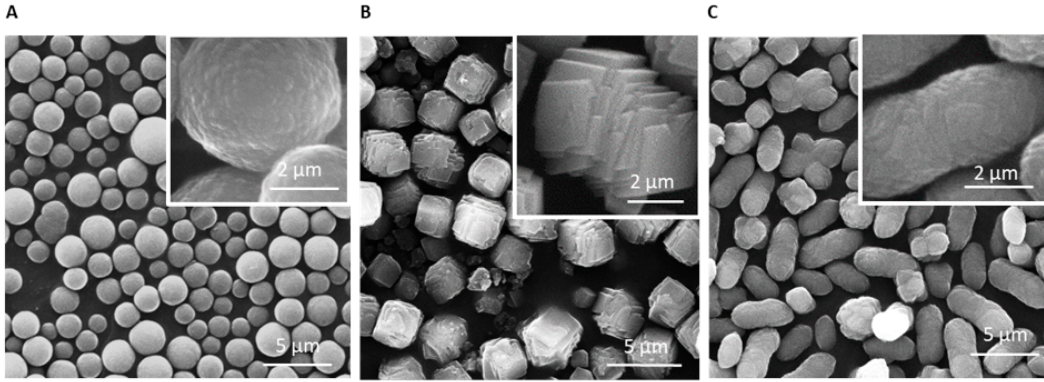
Figure 1. Calcium carbonate fabricated with CMC produces polymorphic samples and heterogenic batches. SEM images ( A – C ) from three independent samples, fabricated with the same standard protocol, show high batch to batch variation. Magnification ×10,000.